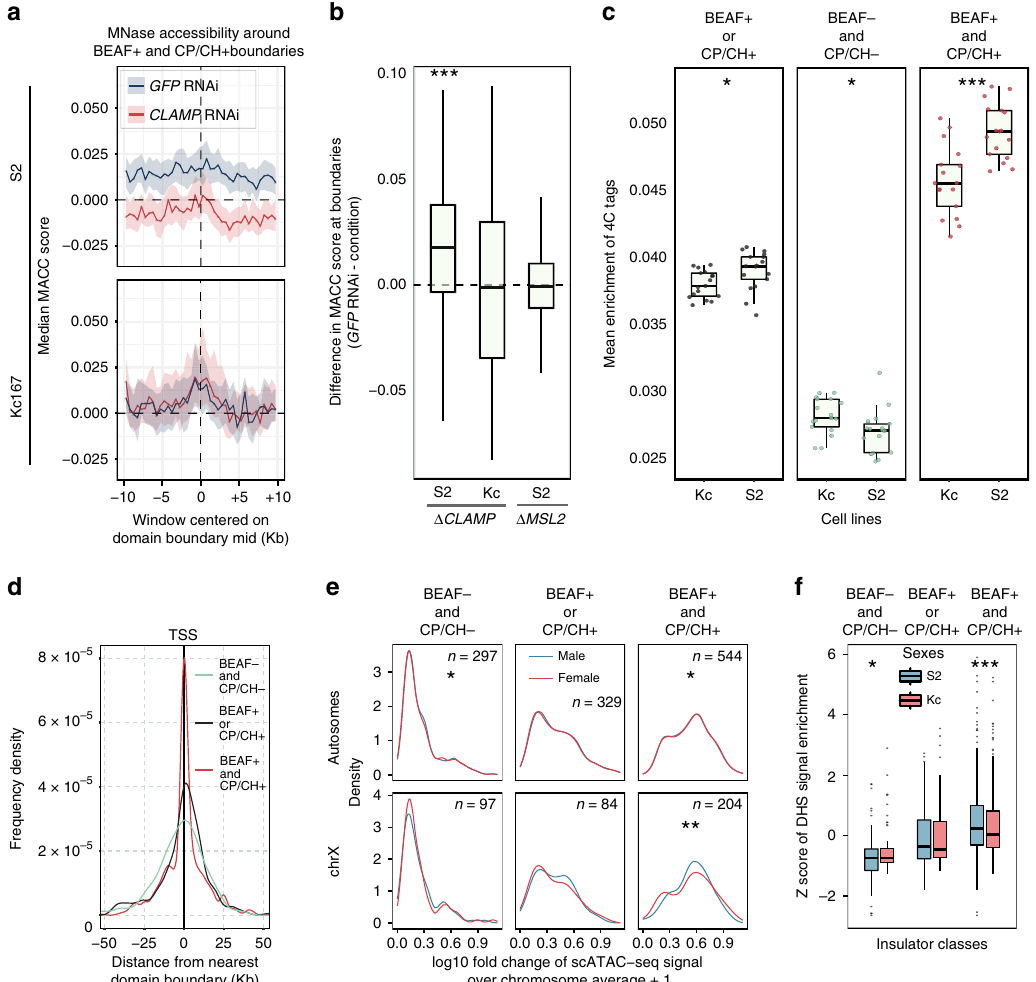
Fig. 5 Independent datasets show higher accessibility of selected boundaries. a MNase-seq metapro fi les around BEAF + and CP/CH + boundaries based on data by Urban et al. 49 . Metapro fi les for both S2 (male, top) and Kc167 (female, bottom) cells are shown and labelled based on the treatment: GFP RNAi (black) and CLAMP RNAi (red) (40th to 60th percentile interval is shown as a shaded area). b The difference between GFP RNAi and CLAMP or MSL2 RNAi MACC score at boundaries ( y -axis) for each S2 or Kc cells sample ( x -axis) (***Wilcoxon test p -value < 0.0001). For each box the median is marked as horizontal line, the boxes mark the interquartile range (IQR), the whiskers extend up to 1.5 IQR, individual data points for outliers beyond this range are omitted. c Mean 4C-seq enrichment signal around (±7 kb) each class of domain boundaries is based on metapro fi les for each 4C probe (each data point in the plot) from Ramirez et al. 8 in male (S2) and female (Kc) cell lines. The difference between S2 and Kc cells is reported (Wilcoxon p -value: ***<0.0001; *< 0.05). Boxplot elements are de fi ned as for panel ( a ), all individual data points are shown. d For each domain boundary class (coloured lines) the distribution of distances to the nearest chrX active gene transcription start site (TSS) is shown. e scATAC-seq signal values in male and female embryos (fold change over chromosome average — see Methods) at the TSS of active genes grouped by the class of the nearest boundary (max ± 10 kb distance) is shown for autosomes (top) and chrX (bottom) for each boundary class. The difference between male and female is marked (Wilcoxon p -value: **<0.01; *<0.05). f DNase-seq signal ( y -axis) ( z -score transformed — see Methods) in cell lines (S2, Kc167) at the TSS of active genes grouped by class of the nearest boundary (max ±10 kb distance) is shown for each boundary class ( x axis top) (Wilcoxon p -value: ***<0.01; *<0.05). Boxplot elements are de fi ned as for panel (a), individual data points are shown for outliers beyond the whiskers